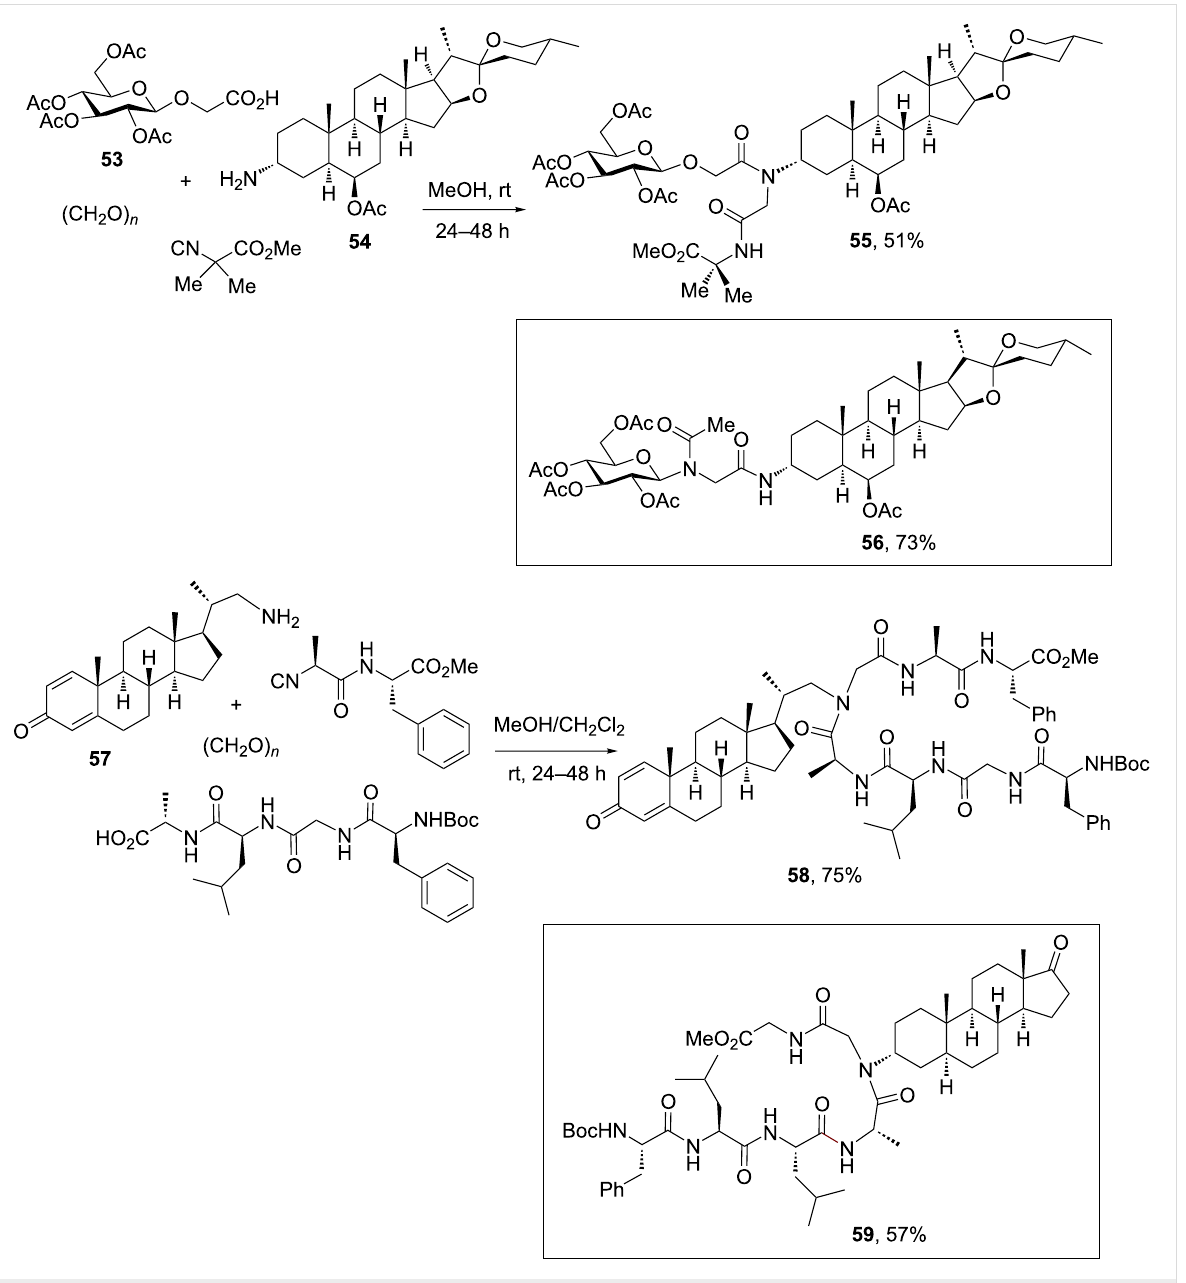
Scheme 17: Conjugation of steroids to carbohydrates and peptides by the Ugi-4CR [62,63].